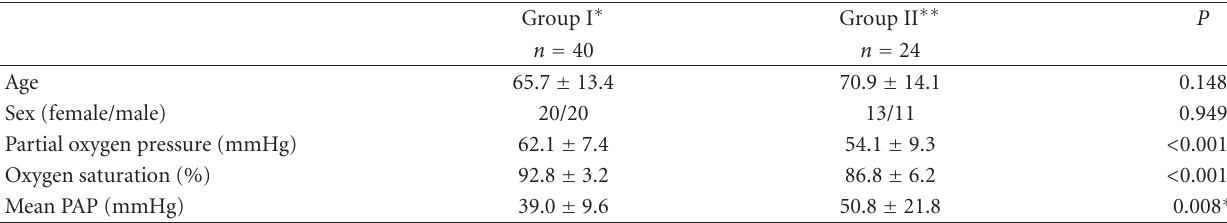
Table 1: Parameters at the beginning of the treatment in Group I and Group II.